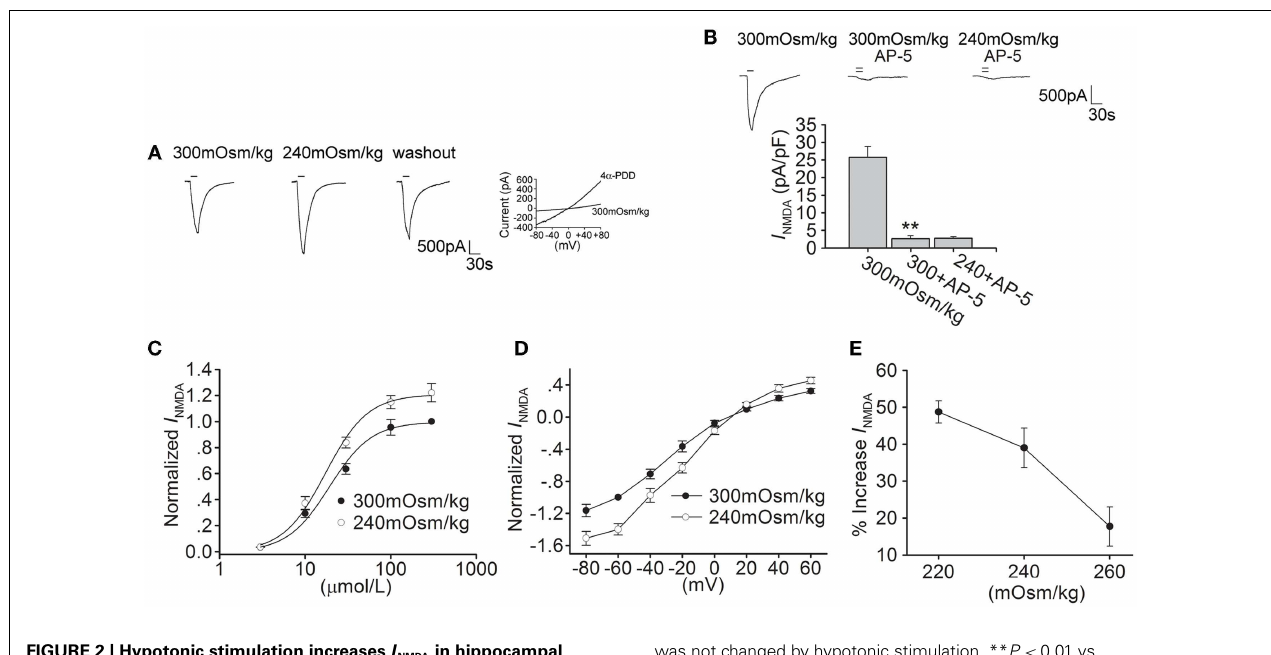
FIGURE 2 | Hypotonic stimulation increases I NMDA in hippocampal CA1 pyramidal neurons. (A) The typical recordings show that I NMDA was increased from − 1.73 to − 2.42nA when the extracellular isotonic solution (300mOsm/kg) was changed to hypotonic solution (240mOsm/kg) and the current recovered to − 1.81nA after washout. 4 α -PDD-evoked current was recorded in the same neuron. (B) I NMDA was reduced from -25.74 ± 3.12 to -2.67 ± 0.87 pA/pF by AP-5 ( n = 6, paired t -test, P < 0.01). Note that in the presence of AP-5, the current